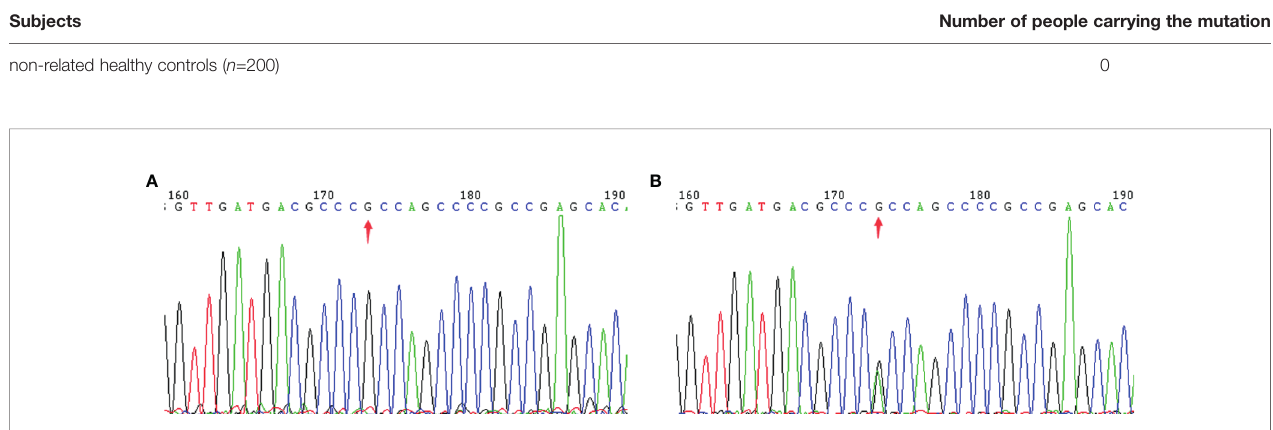
FIGURE 2 | A mutation in the GCK gene causes MODY2. (A) : GCK wild type; (B) : GCK heterozygote.